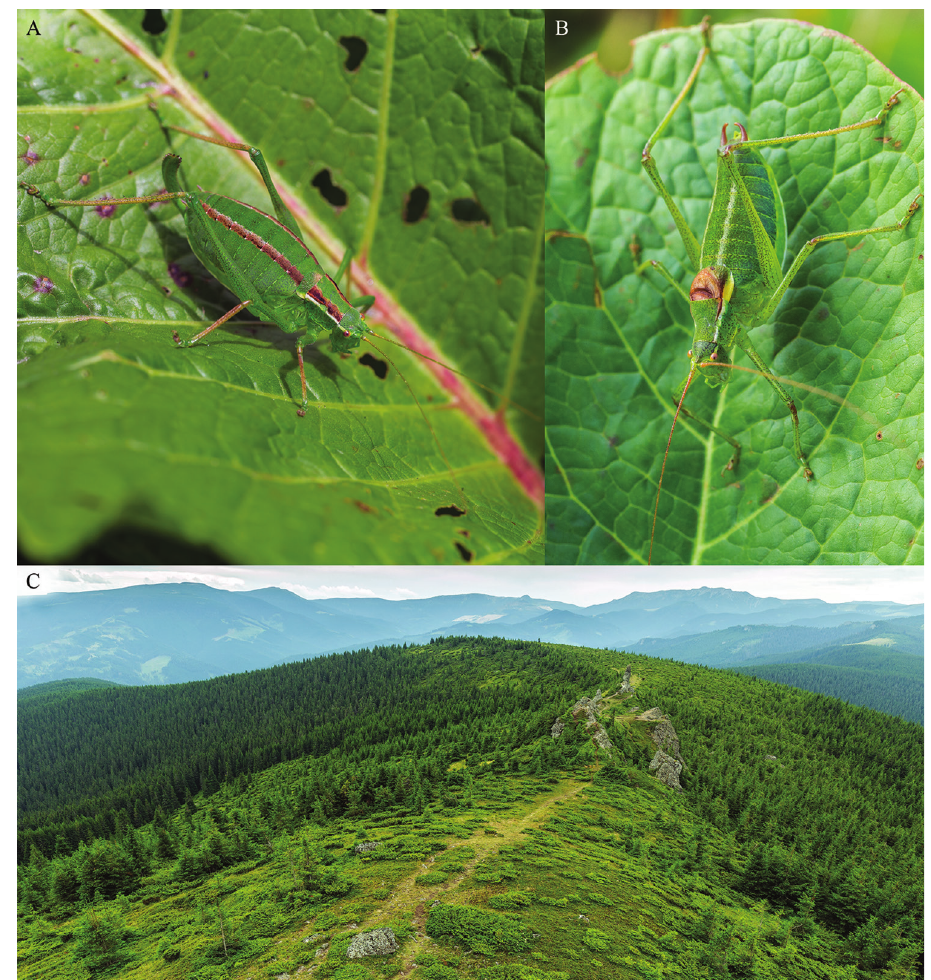
Figure 1. Isophya bucovinensis sp. n.: A female habitus B male habitus C habitat in Călimani Mountains, at 12 Apostoli Peak (1730 m asl) on 27 July